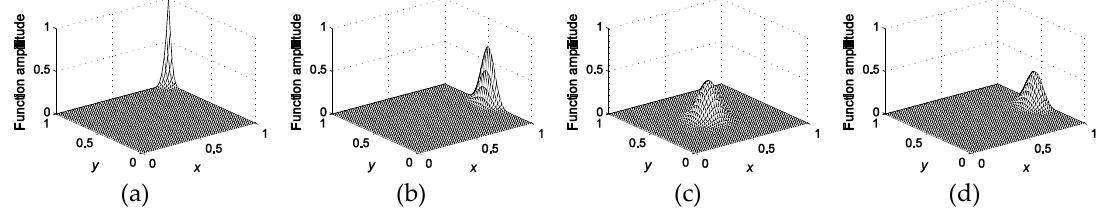
Figure 1. Some typical two-dimensional B-spline wavelets on interval BSWI4 3 scaling functions: ( a ) corner function; ( b ) boundary function; ( c ) inner function; ( d ) partly inner function.